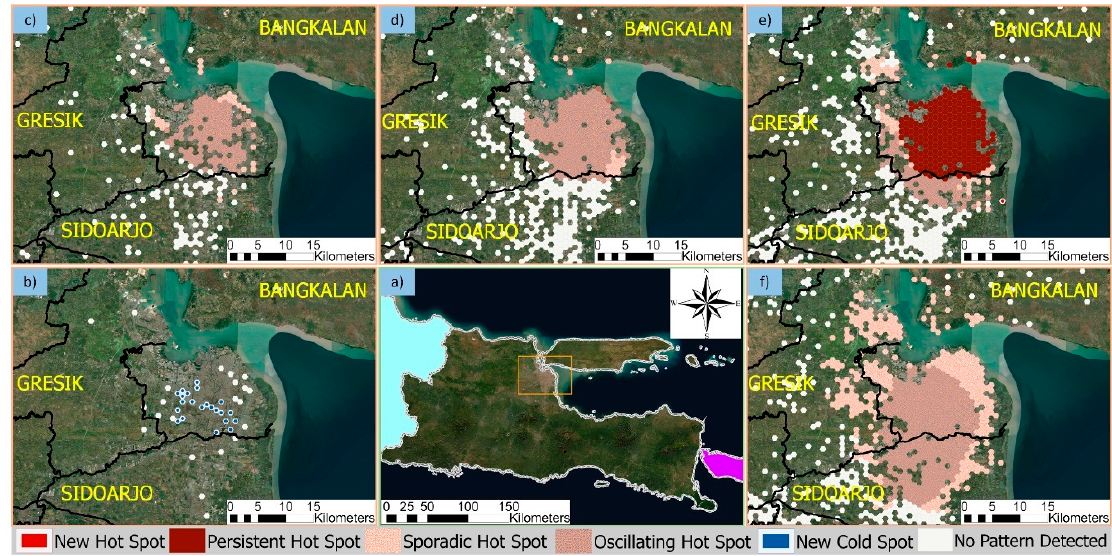
Figure 7. Hotspot/cold spot area detected in ( a ) Greater Surabaya in ( b ) March, ( c ) April, ( d ) May, ( e ) June, and ( f ) accumulated four months. Colors represent the degree of case severity (refer to Tables A1 and A2 for color information).